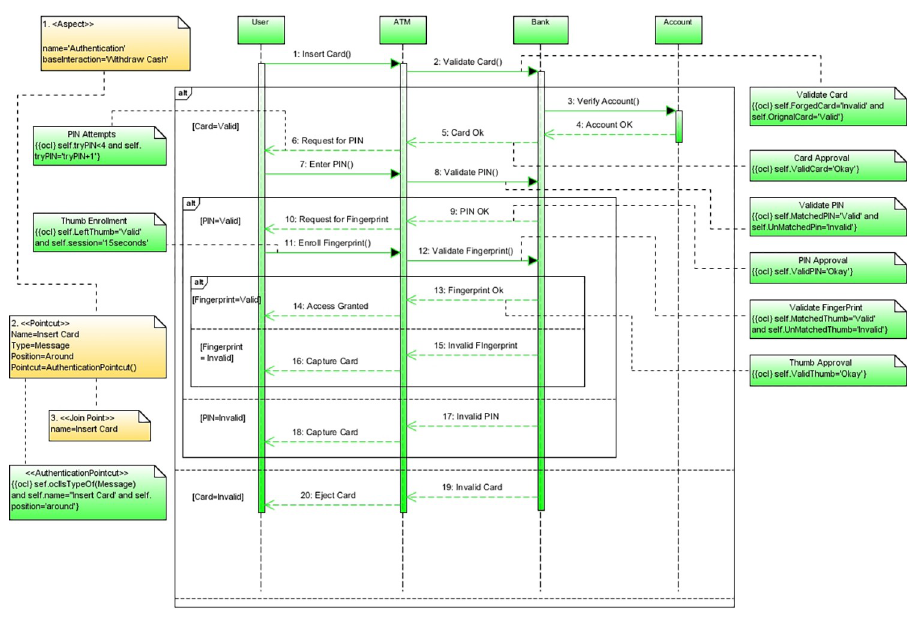
Fig 9. Mal sequence